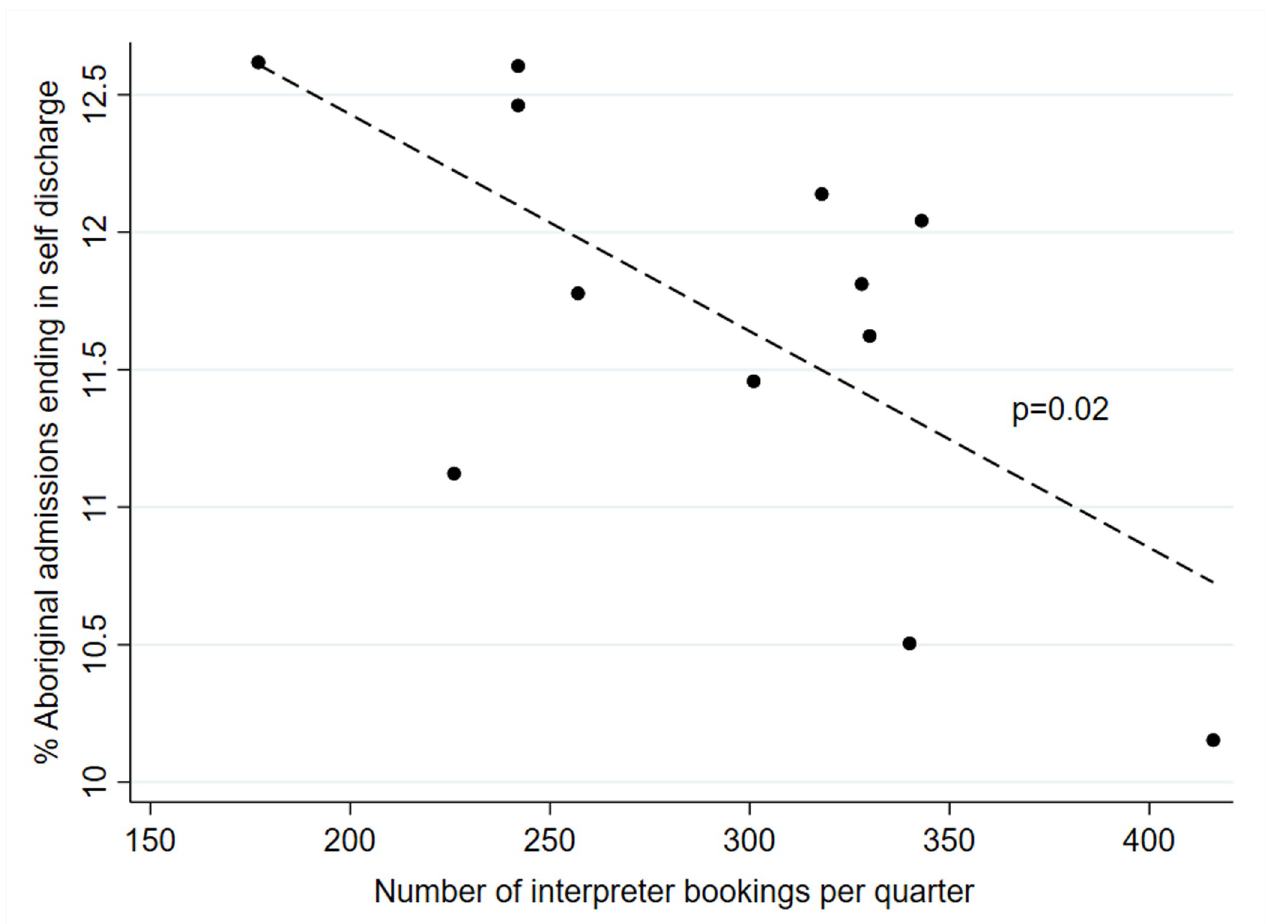
Fig 2. Self discharge rates among Aboriginal inpatients according to number of interpreter bookings made per quarter during baseline and study intervention period (April 2016 to March 2019). Dashed line shows line of best fit. P value derived from linear regression